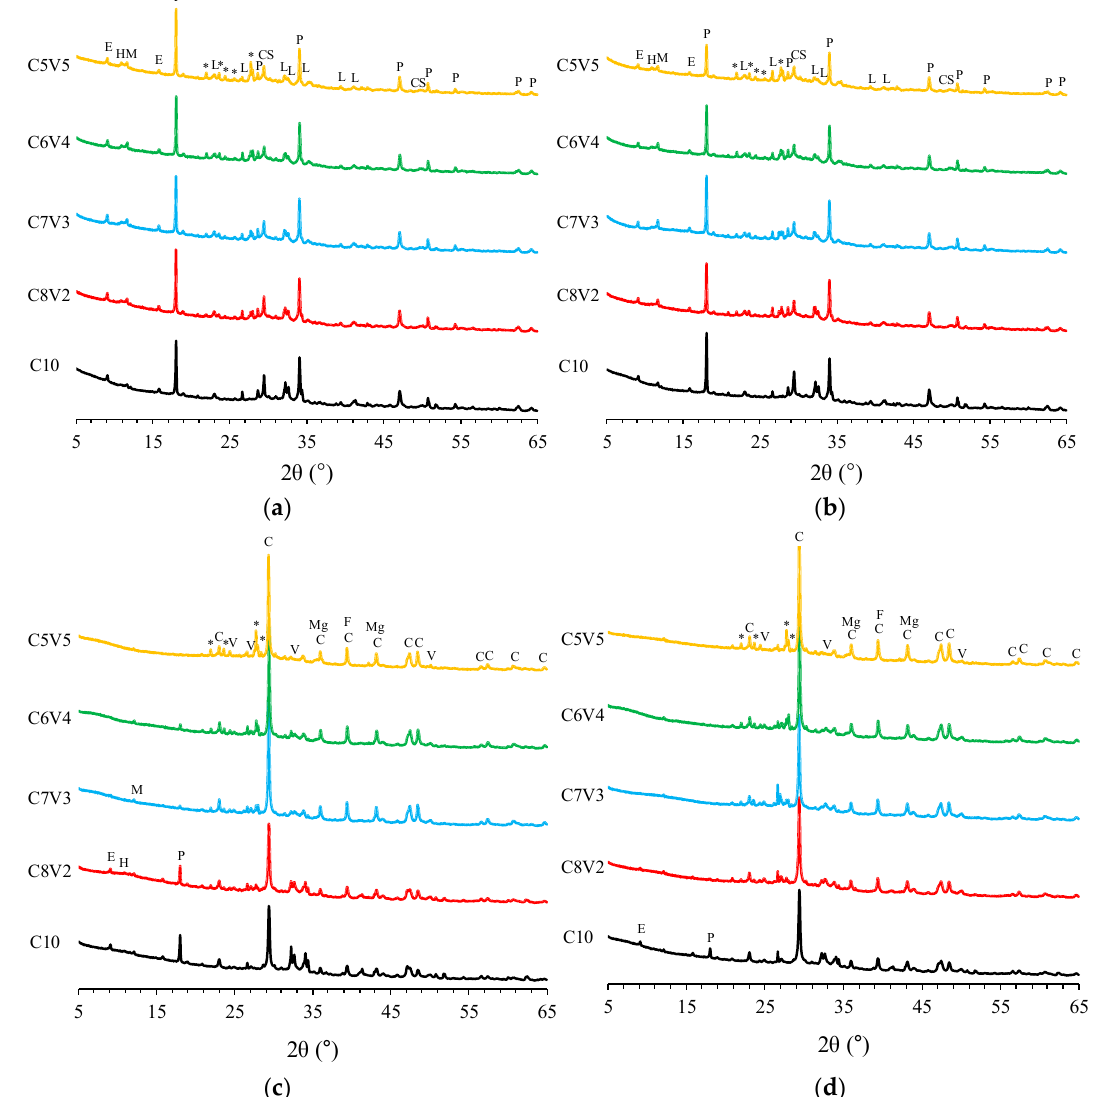
Figure 4. XRD patterns of normally cured and carbonation-cured volcanic ash-blended PC: ( a ) Normally cured 7 days; ( b ) normally cured 28 days; ( c ) carbonation-cured 7 days; ( d ) carbonation-cured 28